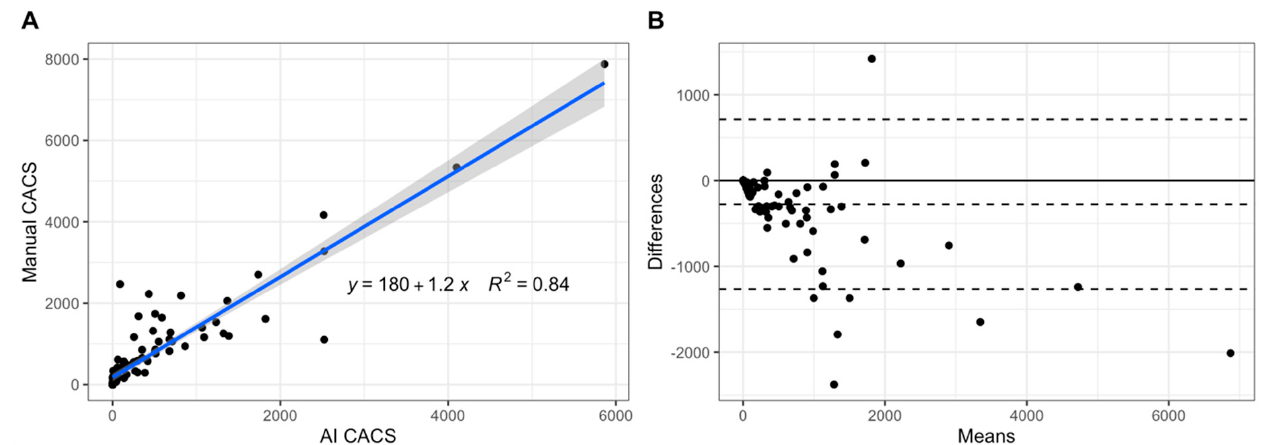
Figure 2. Scatter plot depicting a linear regression model between CAC scores from AI-CACS and manual CACS ( A ) as well as a Bland–Altman plot showing the relationship between CAC scores from AI-CACS and manual CACS ( B ).